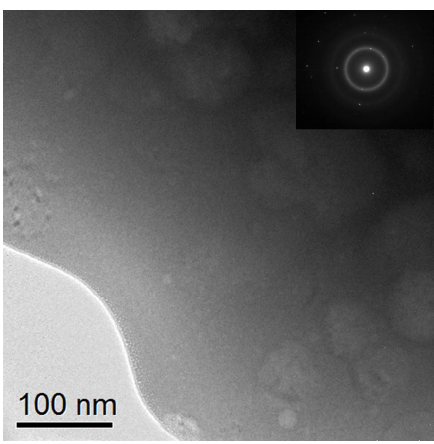
Figure 2. Transmission electron microscope (TEM) images of typical microstructure of the as-sprayed coating: Coexistence of amorphous phase and nanocrystalline grains.